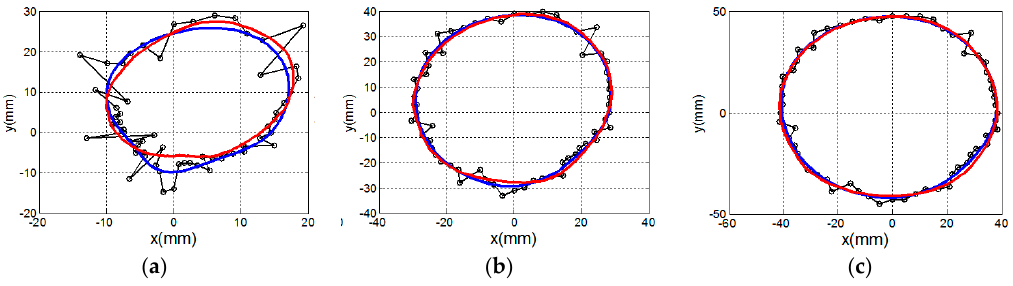
Figure 8. Contour of surface model estimated at three different heights for model C. Estimated contour (blue) fitted to laser points (black dots connected with black lines). Actual contour is represented with red line. Contour near: ( a ) nipple region, ( b ) middle of model, and ( c ) chest wall.